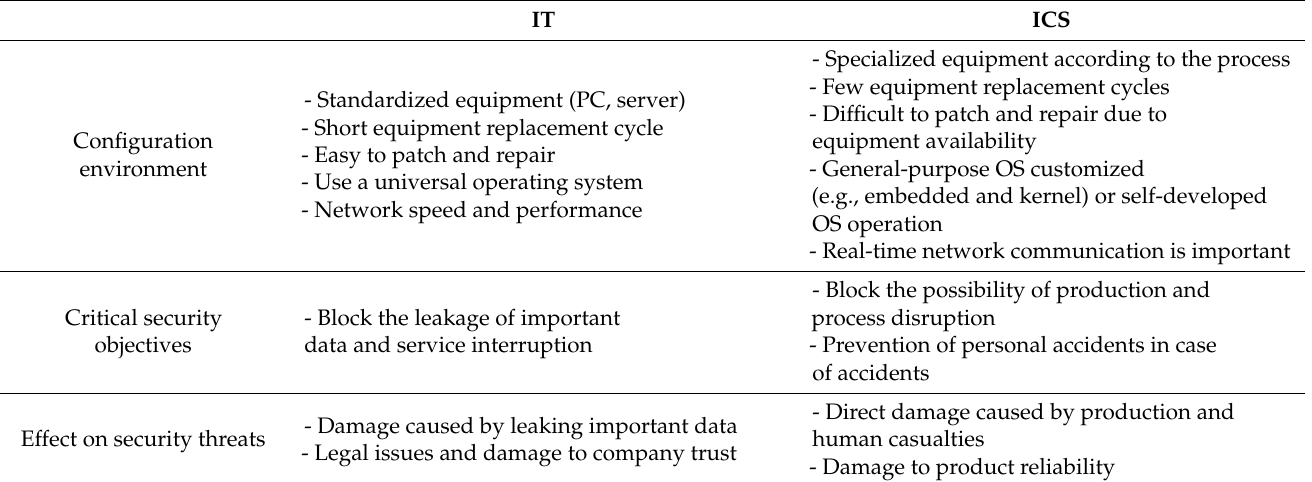
Table 1. Difference between IT and an ICS.